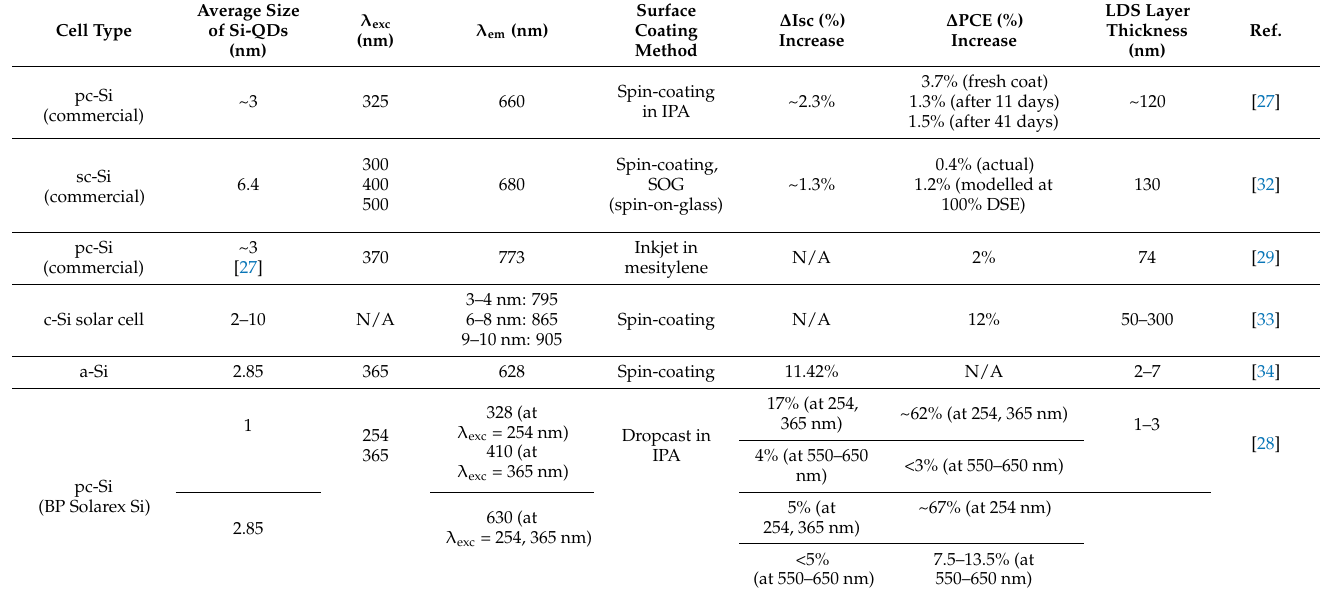
Table 1. Overview of Si-QDs used on Si solar cells and enhancements achieved by previous